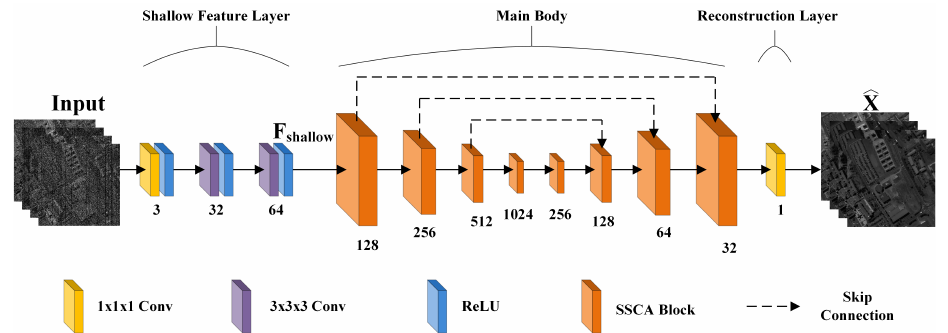
Figure 2. Architecture of our model SSCANet. The digit below the block indicates the block’s matching output